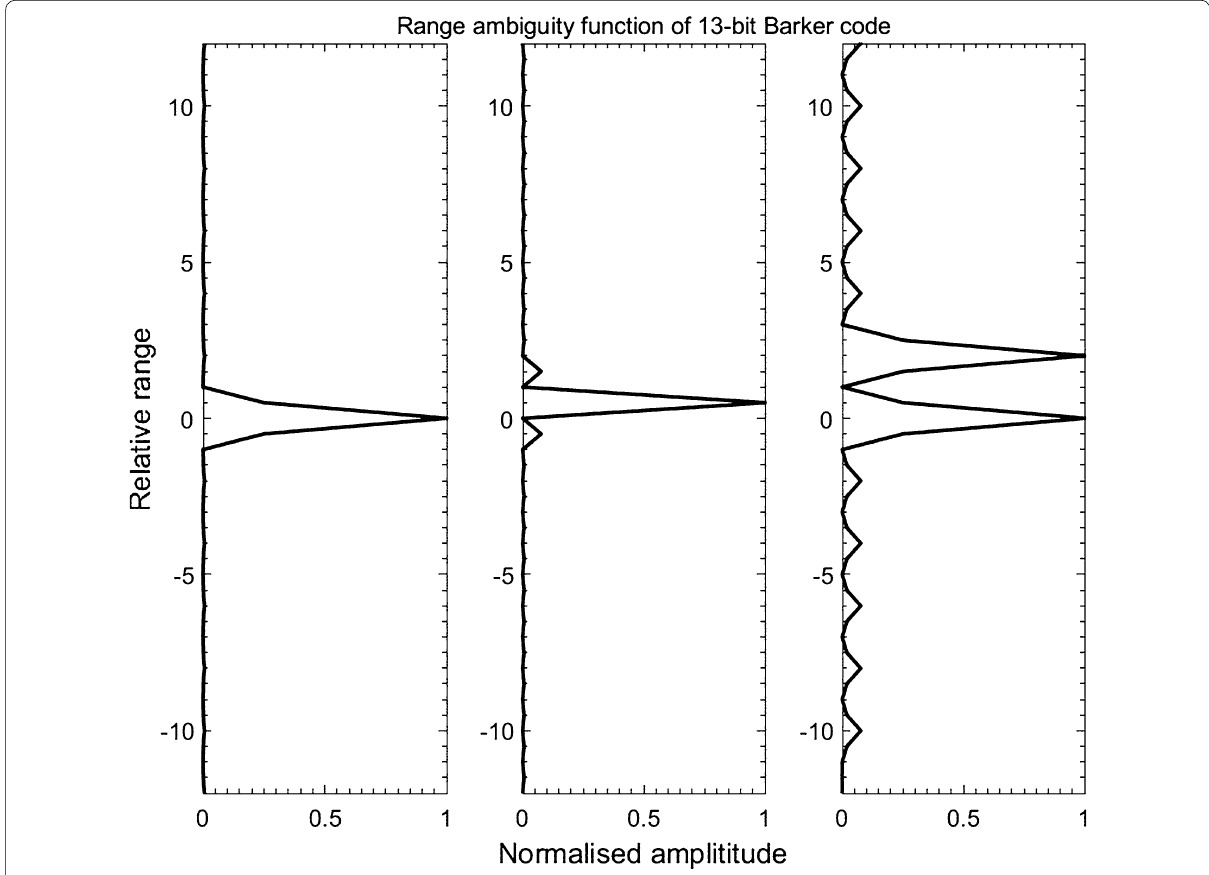
Fig. 9 Range ambiguity function of the 13-bit barker